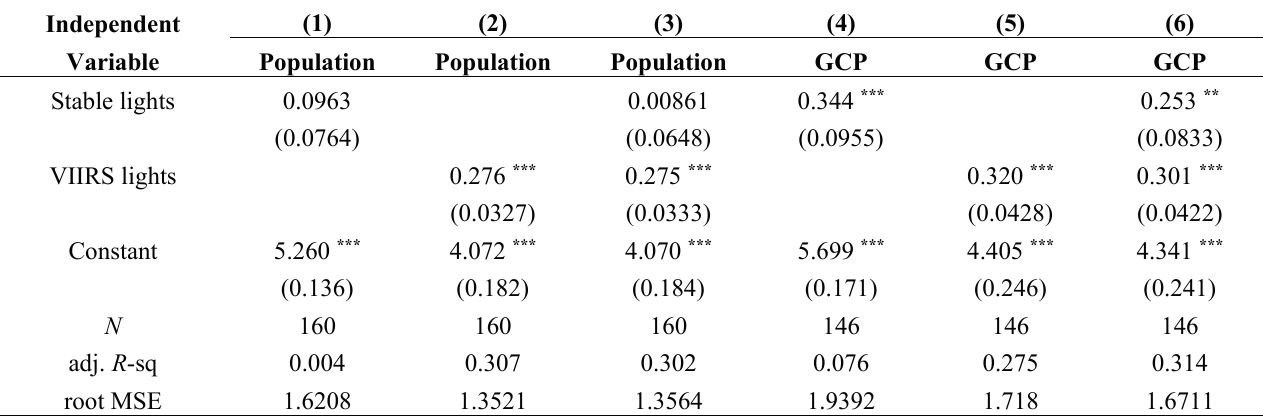
Table 7. Operational Linescan System (OLS) regression for cells with population less than 1000 ( ** p < 0.01; *** p < 0.001).